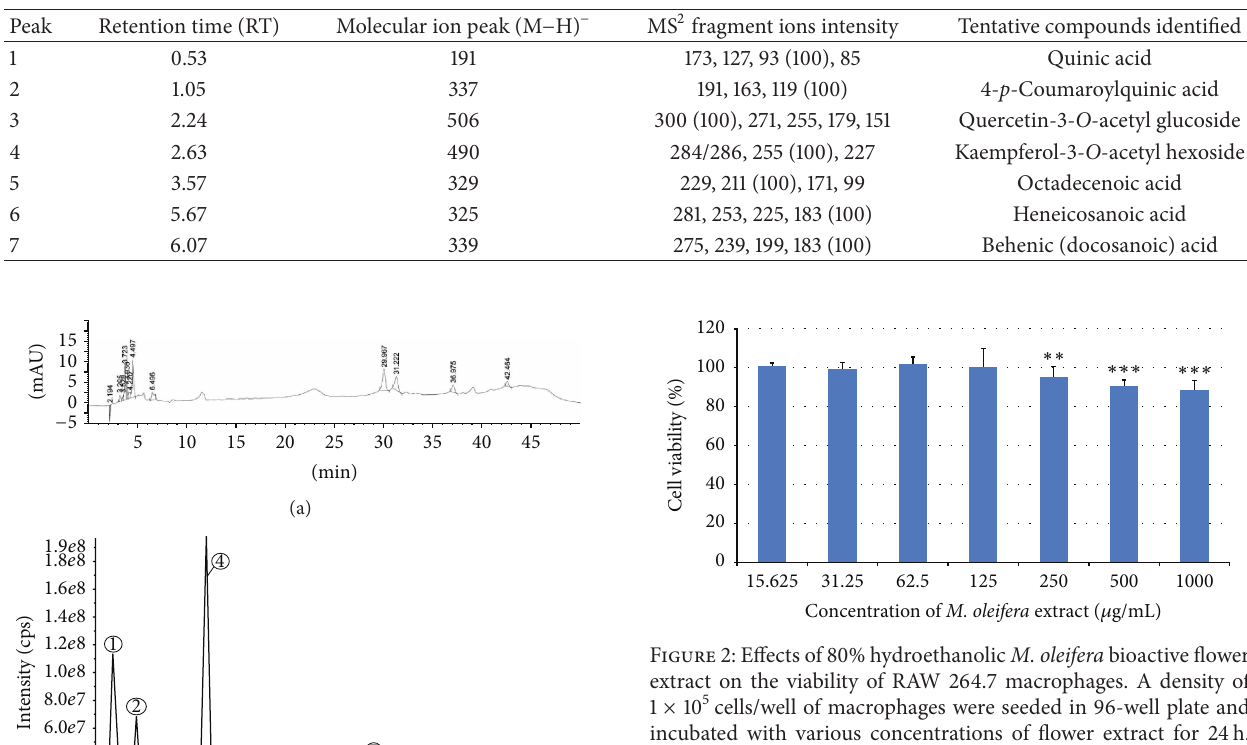
Table 1: Retention times, MS, and MS fragments of the major bioactive constituents present in hydroethanolic M . oleifera crude flower extract by HPLC–DAD–ESI–MS/MS.